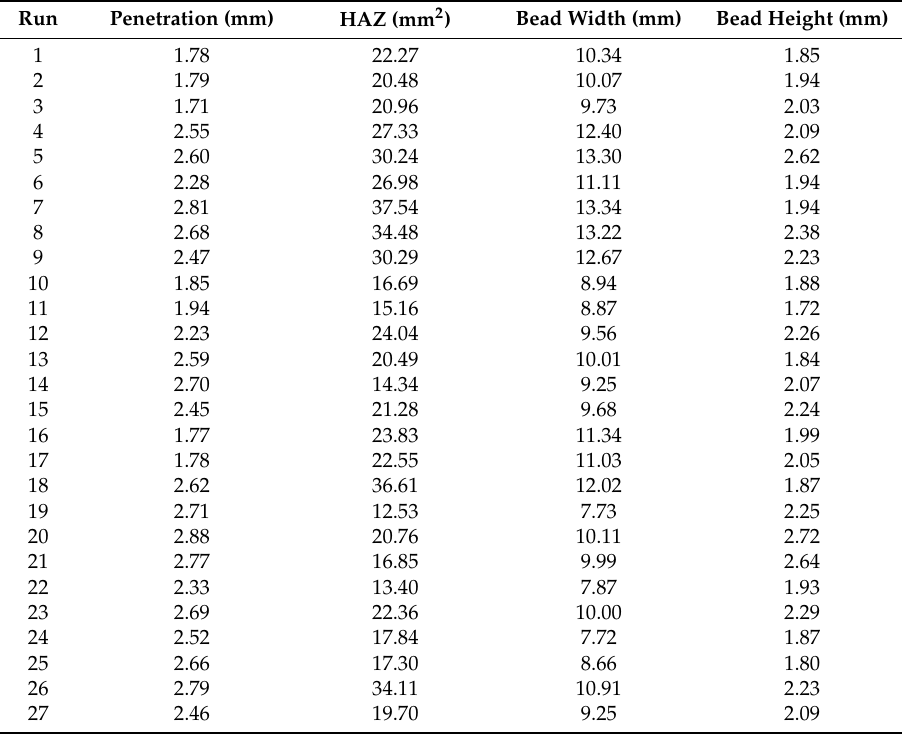
Figure 2. Macrographs of 27 specimens showing the effect of parameters on the weld bead geometry. Table 2. Mean values to the responses. HAZ, heat-affected zone.